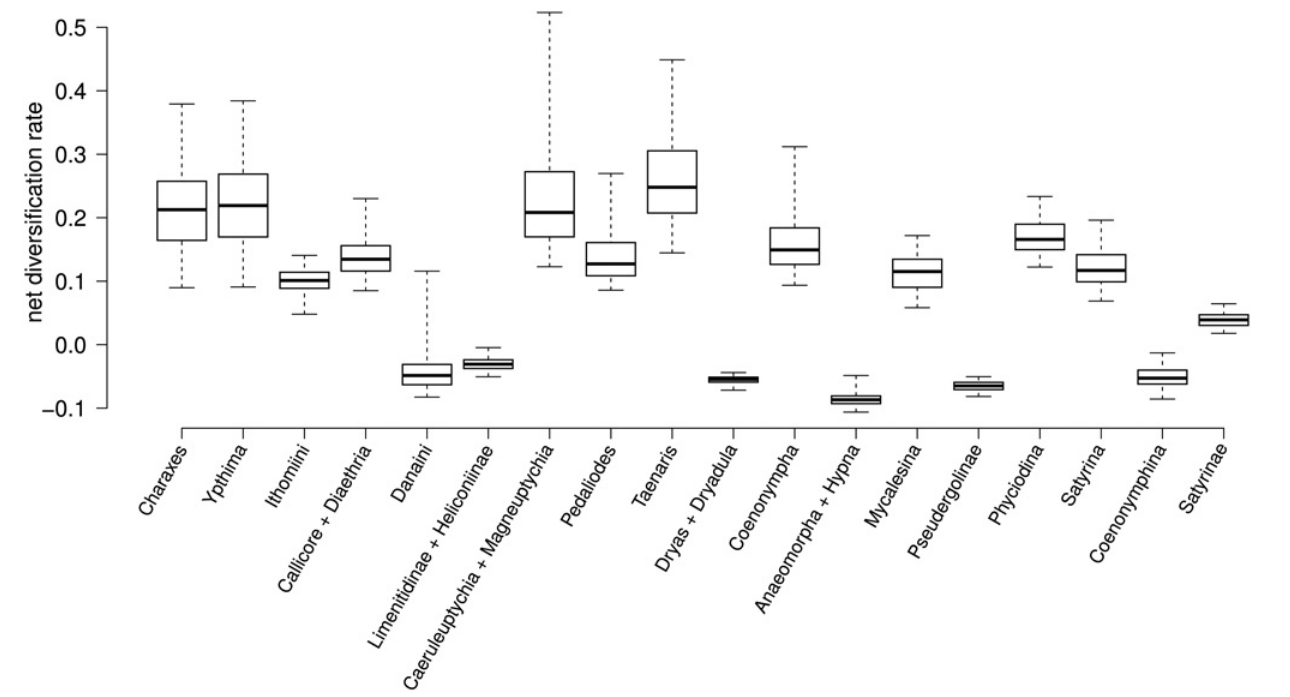
Fig 2. Diversification rates for taxa estimated by MultiMEDUSA on the samples of 1000 random